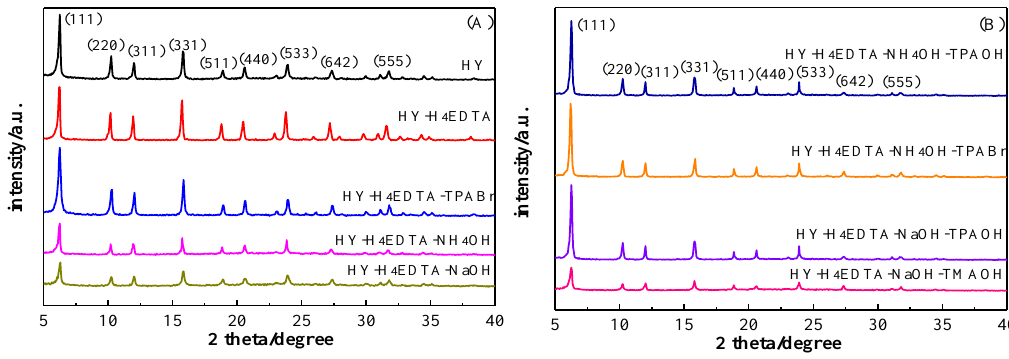
Figure 1. XRD patterns of the parent HY and the optimized hierarchical HY zeolites ( A ) and ( B ).